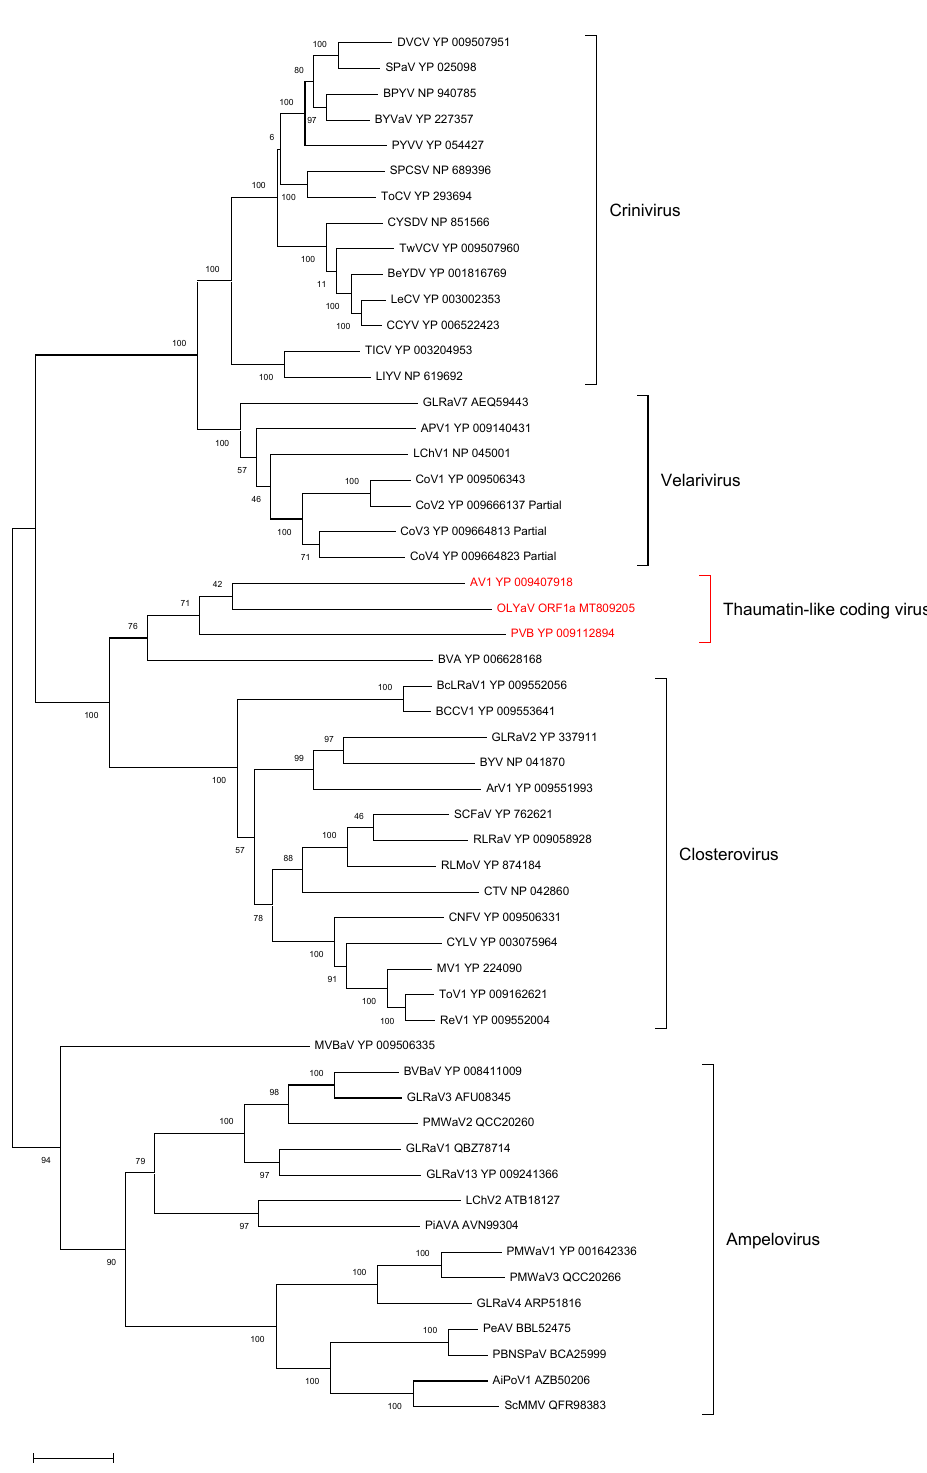
Figure 6. Maximum likelihood phylogenetic tree using the best substitution model by MEGA X of ORF1a from representative members of the family Closteroviridae . Proteins of the isolates are identified by their protein_id number. The scale bar shows the genetic distance. Bootstrap percentages (500 re-samples) are indicated on the branches.